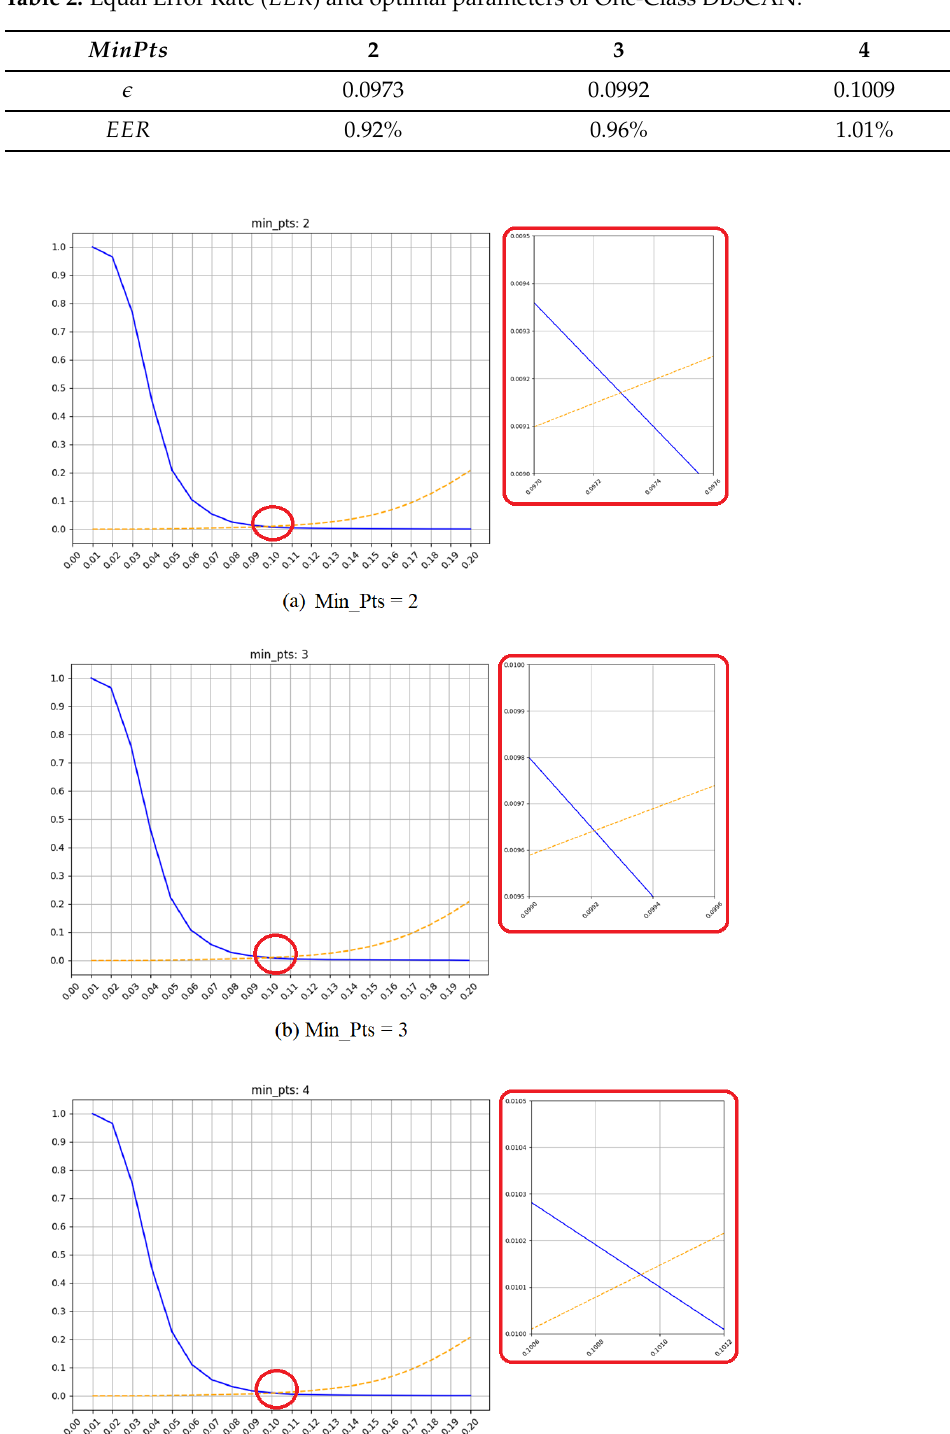
Table 2. Equal Error Rate ( EER ) and optimal parameters of One-Class DBSCAN.